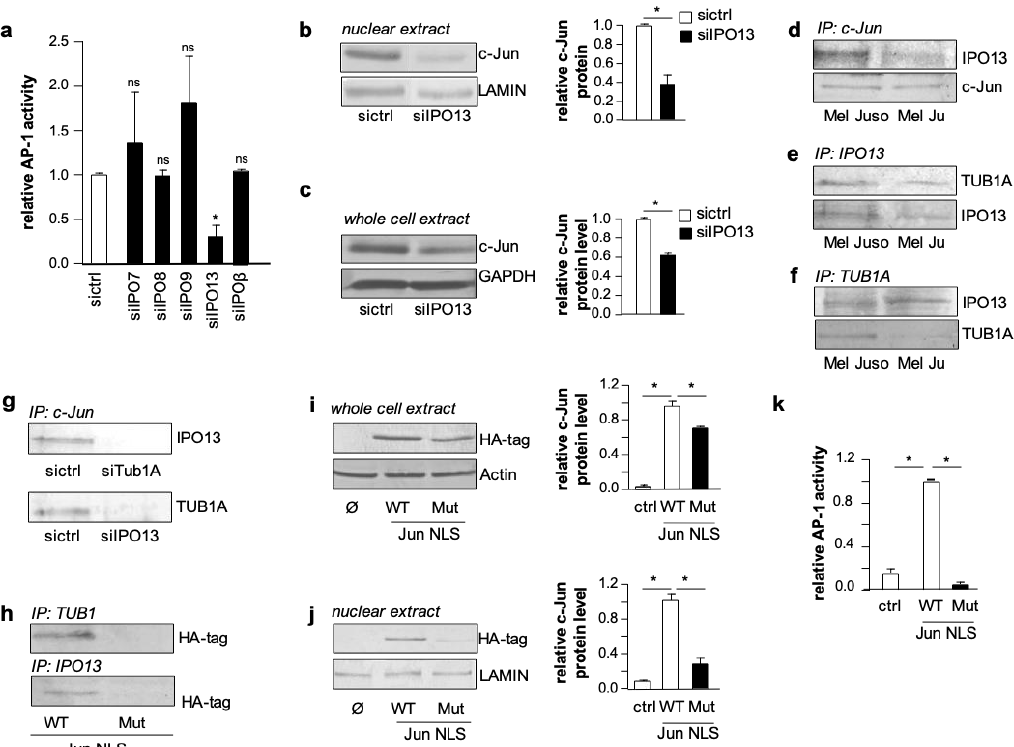
Figure 3. Stabilization of c-Jun by TUB1A influences nuclear import of c-Jun by IPO13. ( a ) AP-1 luciferase reporter gene activity in Mel Juso cells with si-RNA mediated suppression of several importins (siIPO7, siIPO8, siIPO9, siIPO13, siIPO β ) and cells transfected with control si-RNA (sictrl). The bar graph shows the means ± s.d. of three independent experiments. (*: p < 0.05 compared to sictrl; ns: not significant). ( b , c ) Analyses of c-Jun protein levels in ( b ) nuclear extracts and ( c ) whole cell extracts of melanoma cells with IPO13 suppression (siIPO13) and control cells (sictrl) by western blot and densitometry. GAPDH or LAMIN served as loading controls. ( d – f ) Immunoprecipitation (IP) analyses of whole cell lysates from Mel Juso and Mel Ju cells performing co-precipitation of ( d ) IPO13 using an anti-c-Jun antibody, ( e ) TUB1A using an anti-IPO13 antibody, and ( f ) IPO13 using an anti-TUB1A antibody. ( g ) Co-IP of Mel Juso cell lysates with si-RNA mediated suppression of TUB1A (siTub1A) or IPO13 (siIPO13) and sictrl using an anti-c-Jun-antibody. ( h ) Co-IP of extracts from Hmb2-5 cells transfected with wildtype JUN nuclear localization sequence (Jun NLS WT) or a Jun plasmid with mutated NLS (Jun NLS Mut) applying anti-TUB1A- or anti-IPO13-antibodies. Depicted are western blots using an anti-HA-tagged antibody for c-Jun detection. ( i ) Western blot analyses and densitometry showing the expression of HA-tagged c-Jun in Hmb2-5 protein lysates after transfection with Jun WT NLS or Jun MUT NLS. β -Actin served as a loading control. ( j ) Western blot analyses and densitometry showing the expression of HA-tagged c-Jun in Hmb2-5 nuclear extracts after transfection with Jun WT NLS or Jun MUT NLS. LAMIN served as a loading control. ( k ) AP-1 luciferase reporter gene activity of Hmb2-5 cells after transfection with Jun NLS WT or Jun NLS Mut. Bar graph shows the means ± s.d. of three independent experiments. (*: p <